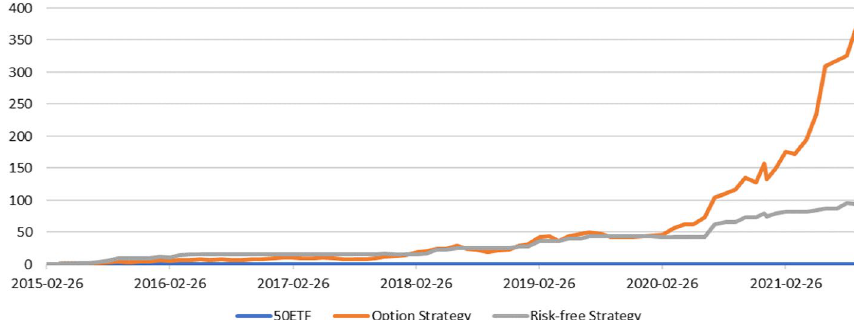
Fig. 5 Cumulative wealth of 50ETF, intelligent option model, and risk-free model. Note : This figure shows the change of accumulated wealth from 2015–02-26 to 2021–09-23, and adjusts each portfolio 80 times. The initial wealth is 1. Since the fluctuation of 50ETF is relatively small compared with the other two strategies, the change of cumulative income is not obvious. The maximum value during this period is 1.4640 and the minimum value is